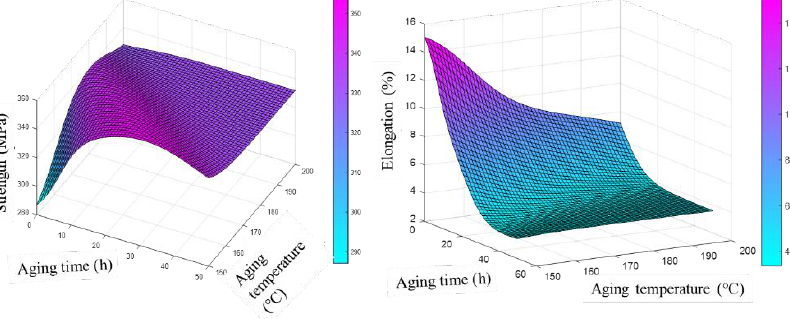
Figure 8. Predicted mechanical properties with aging parameters.